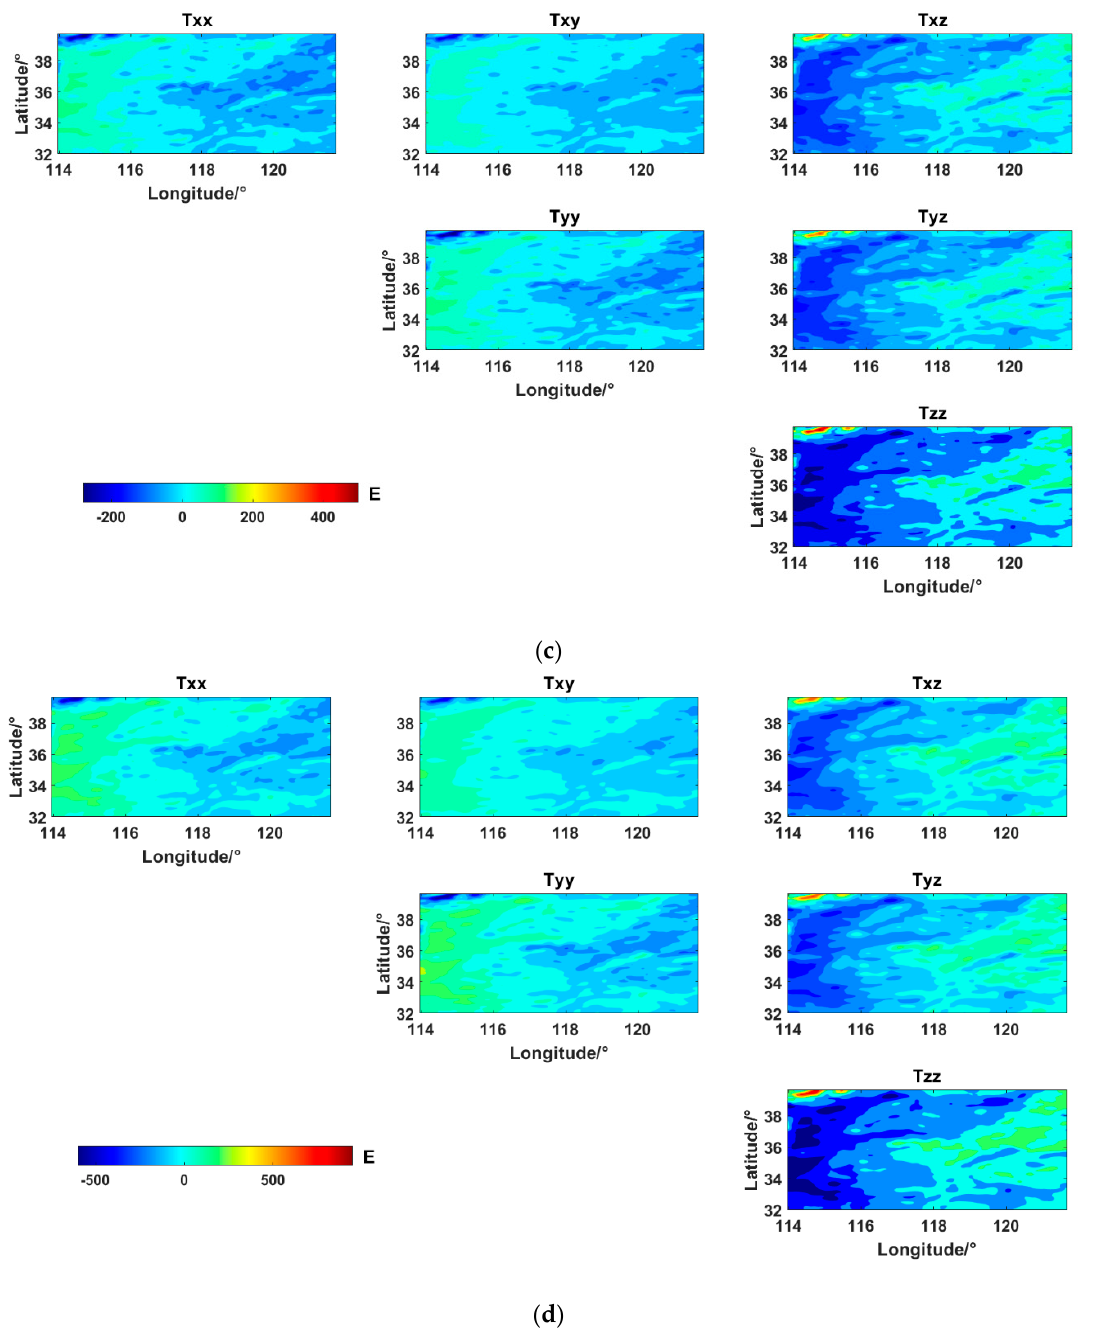
Figure 3. Diagram of inversion results from the North China Plain: ( a ) 5 × 5 truncation order, ( b )